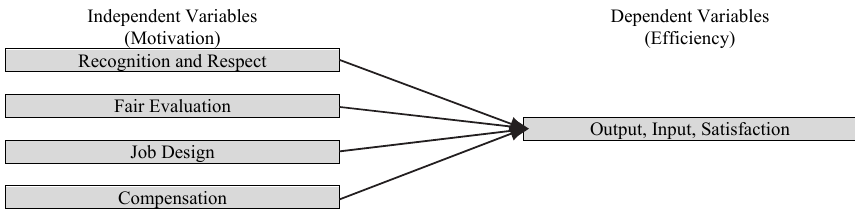
Fig. 2. Conceptual